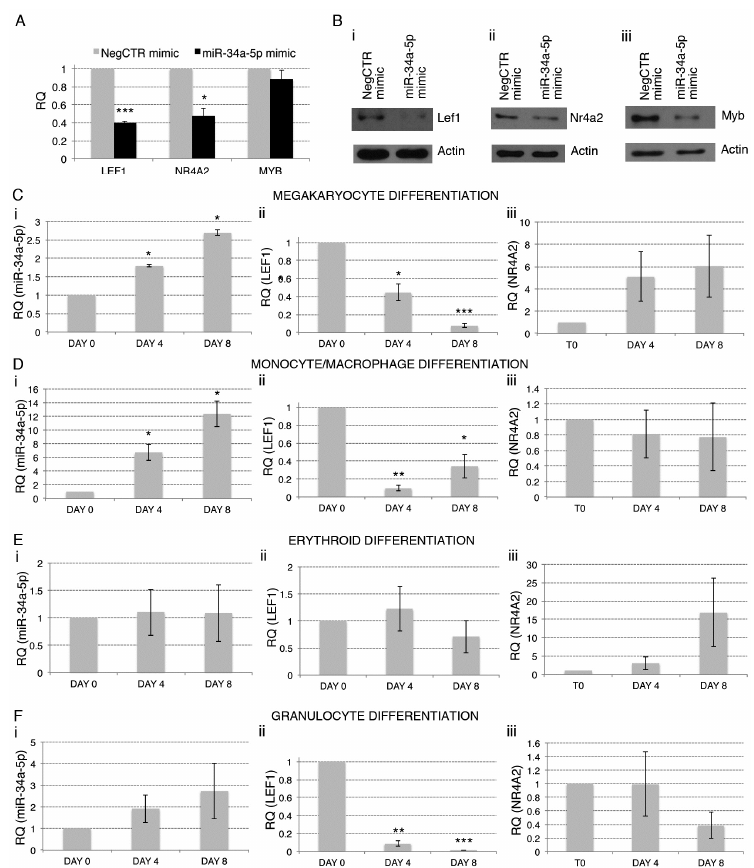
Figure 4. Relationship between the expression of miR-34a-5p and that of the miR-34a-5p targets during the HPCs commitment. ( A ) Detection of lymphoid enhancer-binding factor 1 ( LEF1 ), nuclear receptor subfamily 4, group A, member 2 ( NR4A2 ) and MYB expression levels by Reverse Transcription Quantitative Polymerase Chain Reaction (RT-qPCR) in Negative Control (NegCTR) mimic and miR-34a-5p mimic-transfected CD34+ cells at 24 h post-nucleofection; ( B ) Western Blotting analysis of Lef1 ( i ), Nr4a2 ( ii ) and Myb ( iii ) protein levels in protein lysates from miR-34a-5p mimic-transfected compared to NegCTR mimic-transfected CD34+ cells at 24 h after the last of two nucleofection cycles. Actin protein levels are reported as loading control; ( C – F ) Expression kinetics of miR34a ( i ), LEF1 ( ii ) and NR4A2 ( iii ) during the megakaryocyte ( C ); monocyte/macrophage ( D ); erythroid ( E ) and granulocyte ( F ) differentiation of CD34+ cells. miR-34a-5p, LEF1 and NR4A2 expression levels were monitored by RT-qPCR at day 4 and day 8 post-CD34+ cells purification. Modulations of miR-34a-5p, LEF1 and NR4A2 transcripts are reported as Relative Quantity (RQ) respect to freshly purified CD34+ cells (DAY 0) sample, which was set as calibrator. Data are from n = 3 independent experiments performed with different healthy donor-derived cord blood units. Values in the graph are reported as mean ± SEM. * p ≤ 0.05, ** p ≤ 0.01 and *** p ≤ 0.001 compared to freshly purified CD34+ cells (DAY 0) sample.